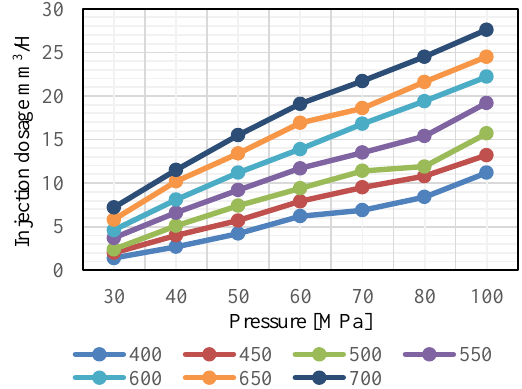
Fig. 2. Standard operating characteristics of the tested fuel injector – parameters measured on the test bench Then, the second operating characteristic was per- formed, but with the injector control times changed (Fig. 3). Based on the parameters from the standard operating characteristics of the fuel injector (Fig. 2), the neural net- work modeled the injection doses for the characteristic with changed control times (Fig.